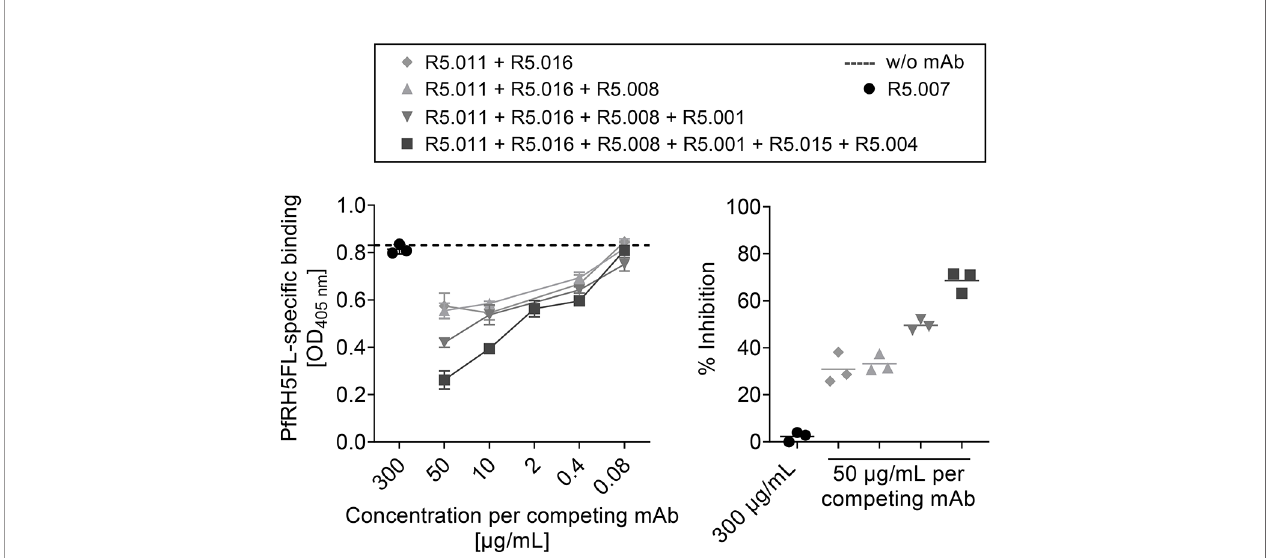
FIGURE 3 | PfRH5FL-speci fi c antibodies raised by vaccination with scFv a MHCII -PfRH5 D NL DNA vaccine competed for epitopes recognized by PfRH5-speci fi c human mAbs. BALB/c mice (n = 6) were vaccinated three times (day 0, 21 and 42) with 50 µg DNA i.m./EP with scFv a MHCII -PfRH5 D NL and sera harvested at day 62. Pooled sera were incubated with a titration (50, 10, 2, 0.4 and 0.08 µg/ml per mAb) of competitor human anti-PfRH5 D NL mAbs as indicated. Binding of total IgG in sera to PfRH5FL was measured (left panel). PfRH5FL-speci fi c total IgG in serum without human mAbs added was indicated (stippled line). Percent (%) inhibition of binding of total IgG in sera to PfRH5FL by competing mAbs (50 µg/mL per mAb) compared to non-competing mAb (R5.007, 300 µg/mL) was calculated (right panel). All samples were performed as technical triplicates (mean ±